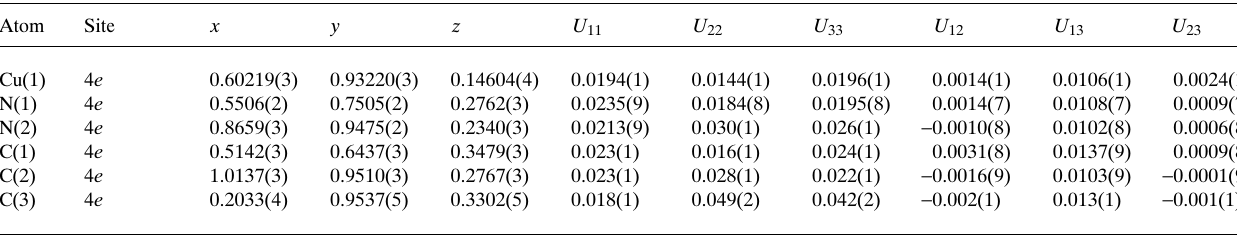
Table 3. Atomic coordinates and displacement parameters (in Å 2 )